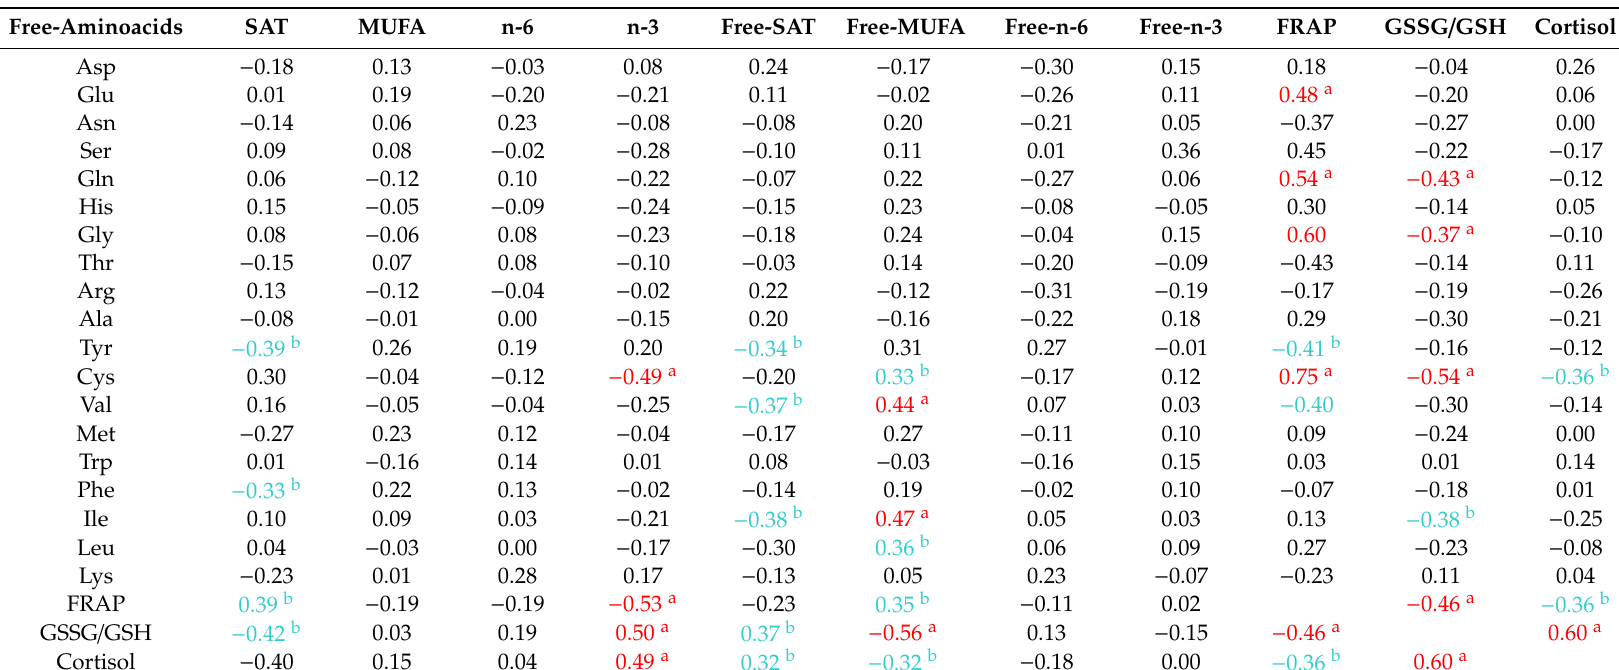
Table 5. Correlation coe ffi cients between plasma amino acids and fatty acids and between antioxidant status: ferric reducing antioxidant power (FRAP) and oxidized glutathione / reduced glutathione (GSSH / GSH) or physiological stress (cortisol) and di ff erent metabolites in